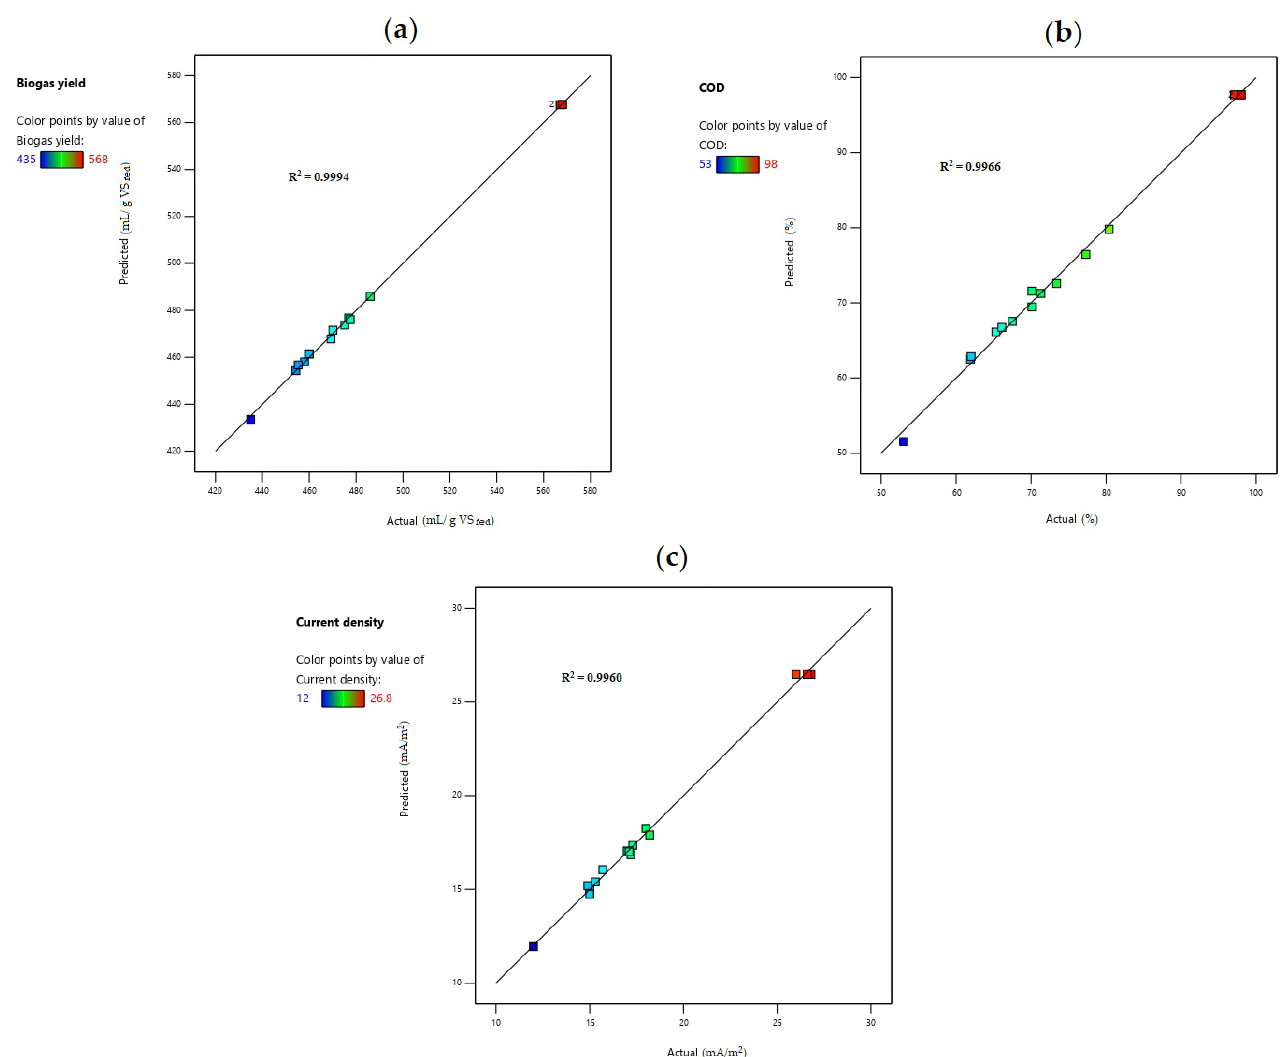
Figure 2. Predicted versus actual values of ( a ) biogas yield; ( b ) %COD removed; and ( c ) current density.